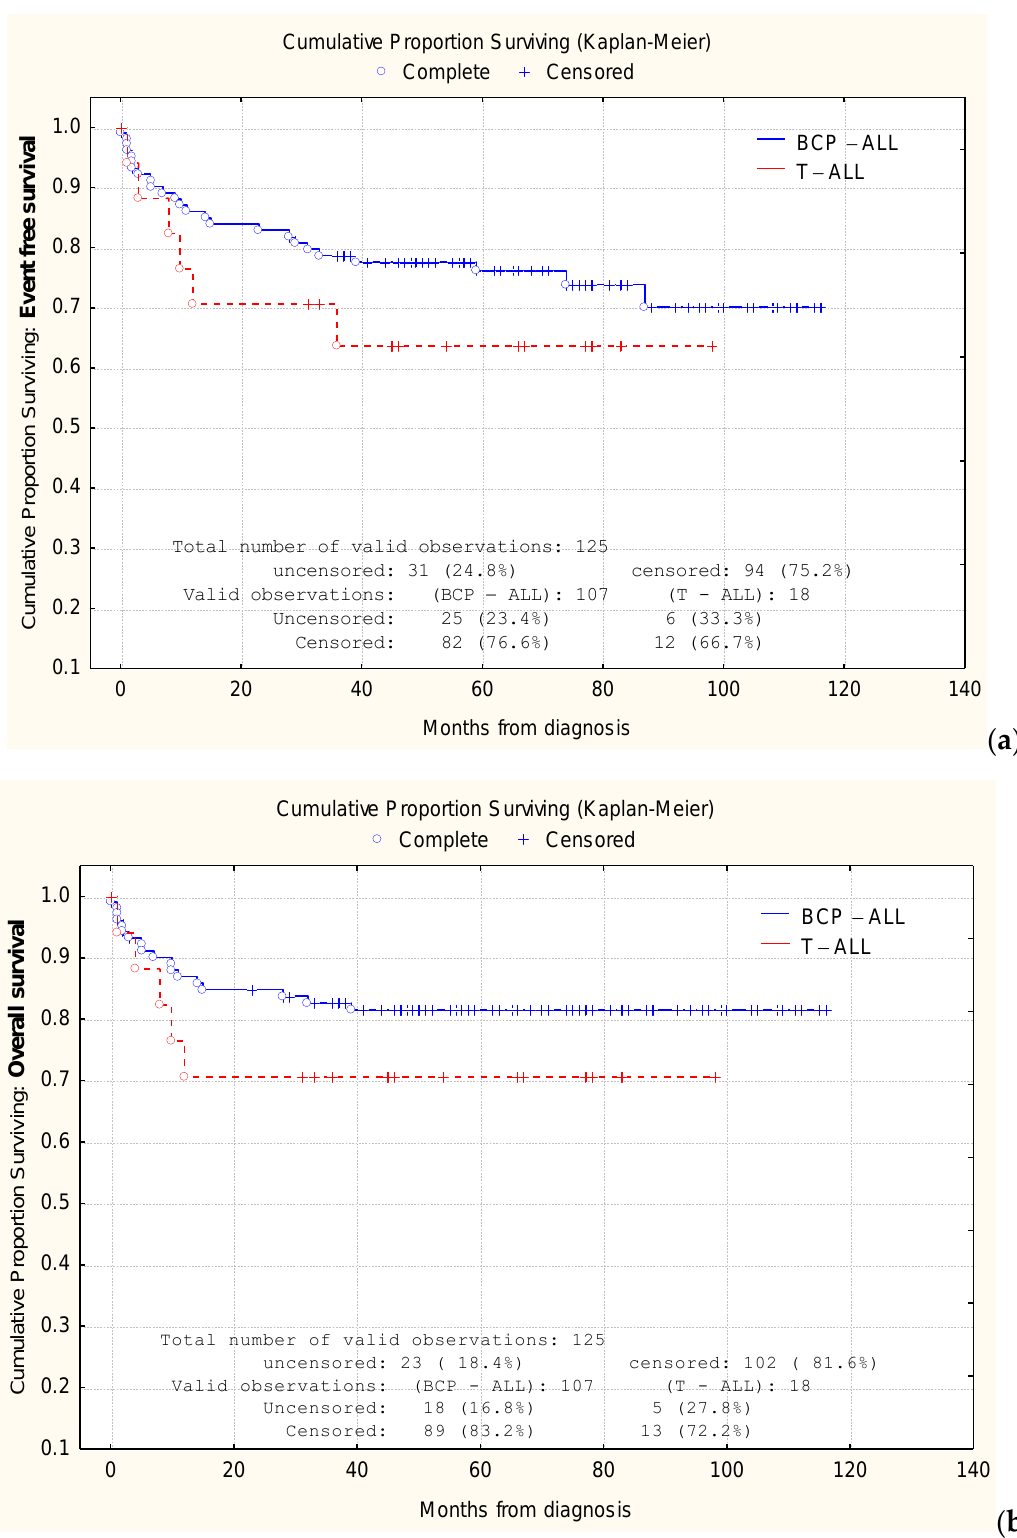
Figure 2. Comparative analysis of Kaplan–Meier curves between precursor B-cell acute lymphoblastic leukemia (BCP-ALL) cases and T-cell acute lymphoblastic leukemia (T-ALL) cases. Comparison of event-free survival (EFS) ( a ) rates and overall survival (OS) rates ( b ). According to our results and observations, risk stratification could have important prognostic value. Higher EFS rates at 90-month follow-up were observed in patients aged between 1 and 4